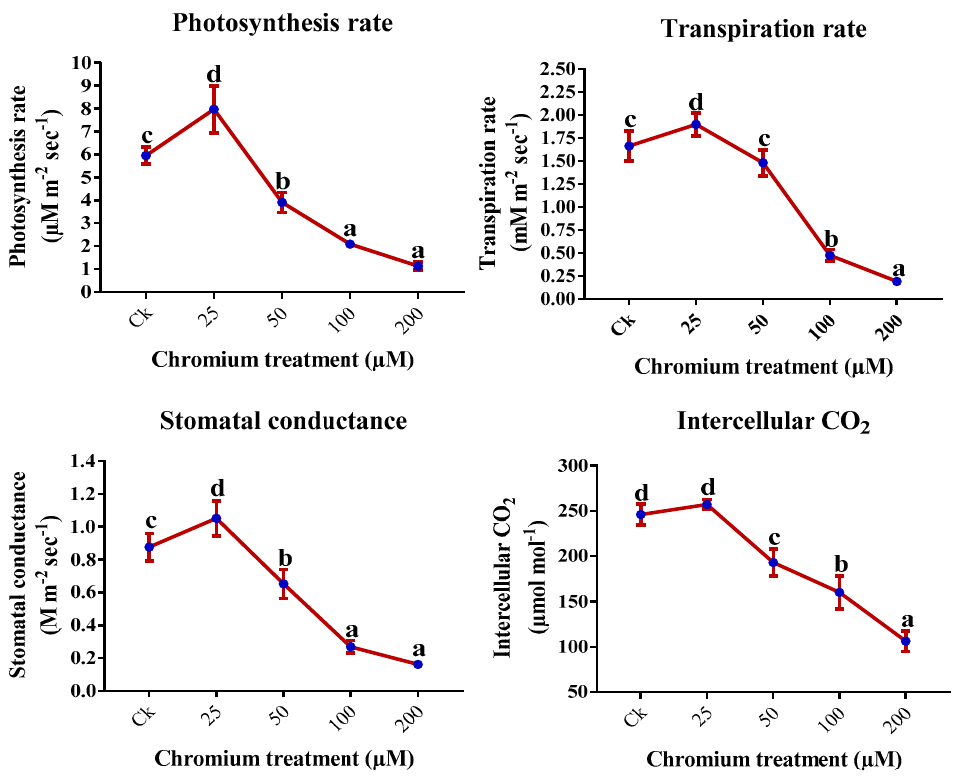
Figure 2. Impact of Cr on gaseous exchange elements in the leaf of sweet potato. Means followed by different letters indicate a significant difference ( p < 0.05) among the five treatments according to the Tuckey test. Error bars show mean ± SE.